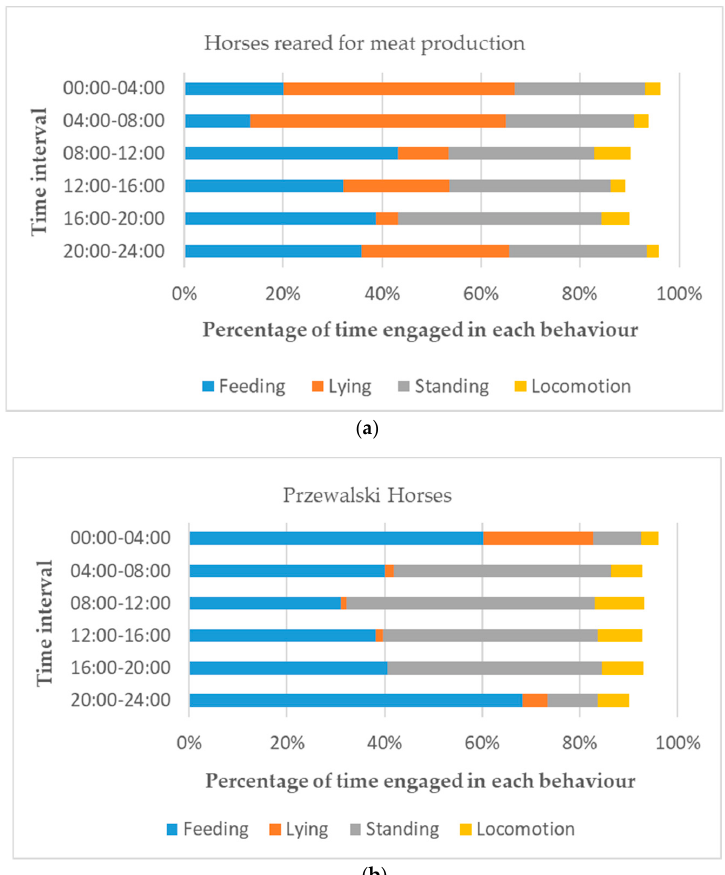
Figure 2. Comparison of the 24 h time frame of the main expressed behavioural activities (standing, feeding, lying, and locomotion) engaged in by the horses reared for meat production ( a ) and wild-living Przewalski horses ( b ) (data adapted from Boyd et al., 1988 [29]).